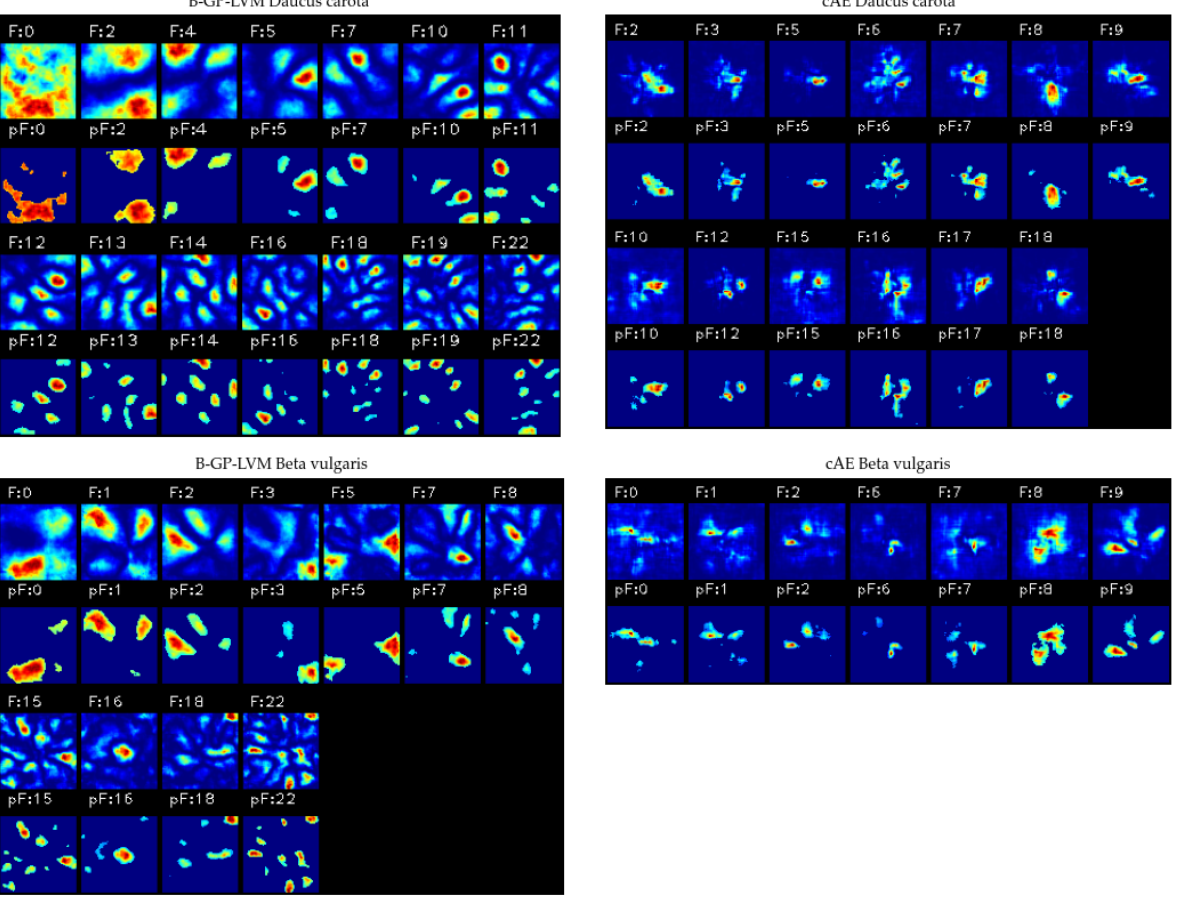
Figure 10. The learned features after feature selection for both data sets and unsupervised models. The images show the extracted features including the feature identification number (e.g., F:0) and the thresholded features using the statistical test’s p value (e.g., pF:0). Both models are able to extract leaf-like structures. The B-GP-LVM was able to extract leaf patches and background such as soil (e.g., F:4 for Daucus carota ). The cAE is able to identify more complex leaf coherence but minor background